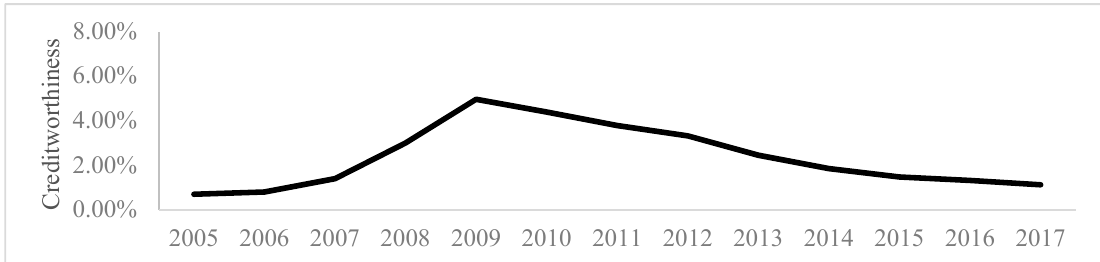
Figure 2. Trend in Creditworthiness .